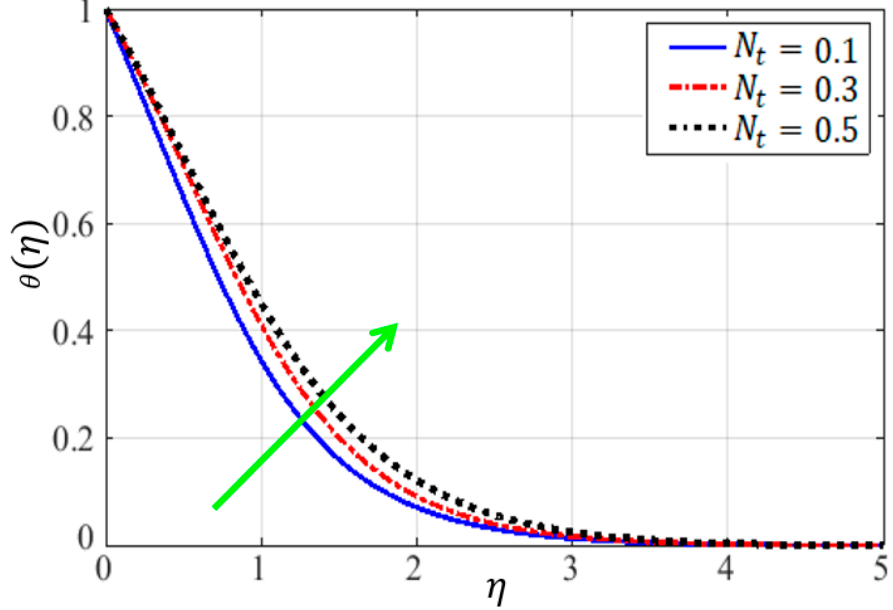
Figure 11. Impact of thermophoresis parameter on temperature fi eld.